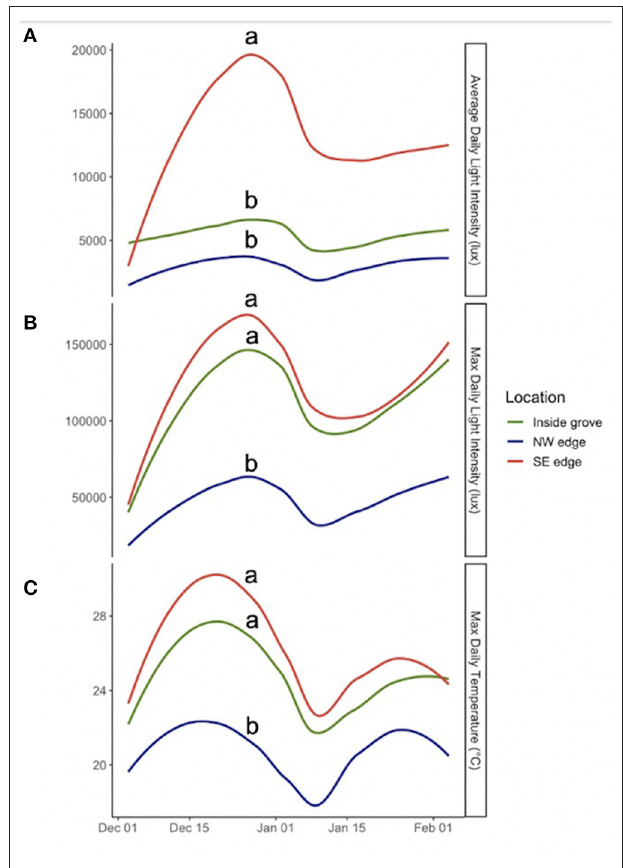
FIGURE 5 | Climate data comparing the interior, NW edge, and SE edge of the groves in December and January of the 2018–2019 overwintering season for (A) average daily light (ADL) intensity (lux), ( p < 0.0001), (B) maximum daily light (MaDL) intensity (lux), ( p < 0.0001), and (C) maximum daily temperature (MaDT) ( ◦ C), ( p < 0.0012). Lines have been smoothed to capture important patterns in the data and reduce noise. In each panel, same letter indicates that locations are not significantly different, while different letters indicate a difference. These are some of the significant results. All results are shown